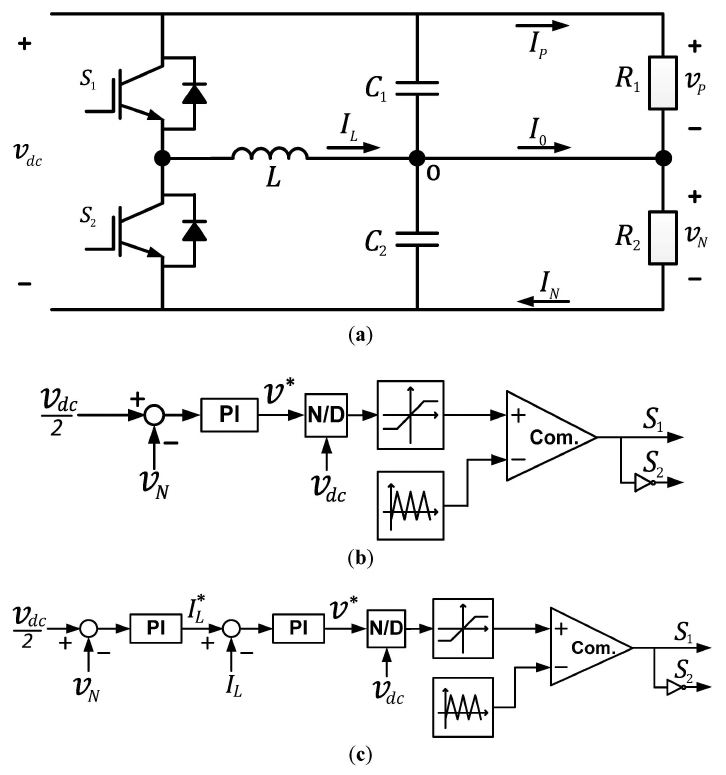
Figure 5. Half-Bridge voltage balancer: ( a ) Power circuit; ( b ) Controller with one PI control; ( c ) Controller with two cascaded PI